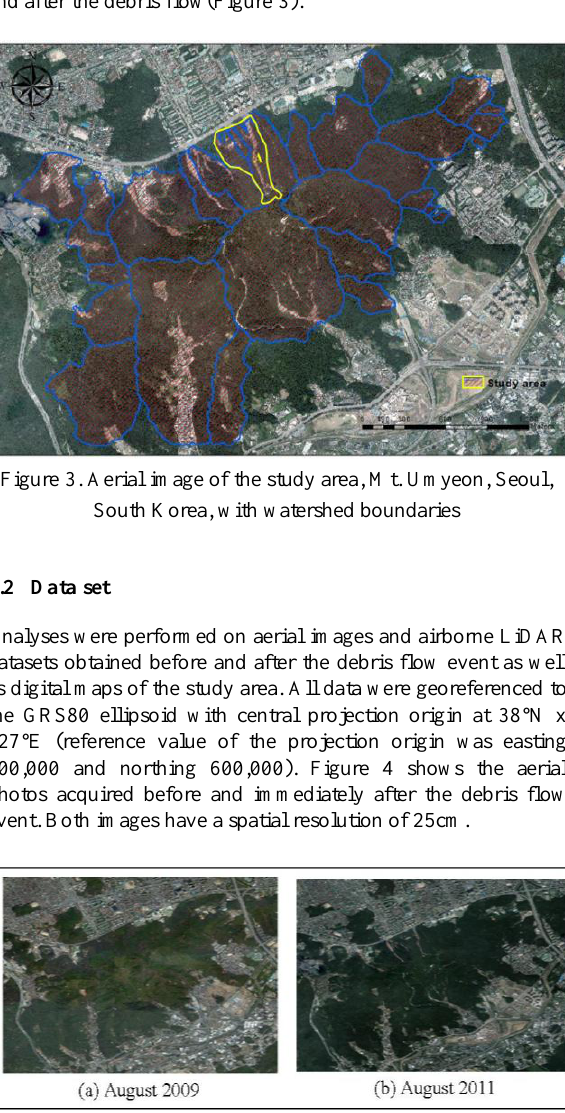
Figure 5. Digital maps of the disaster area